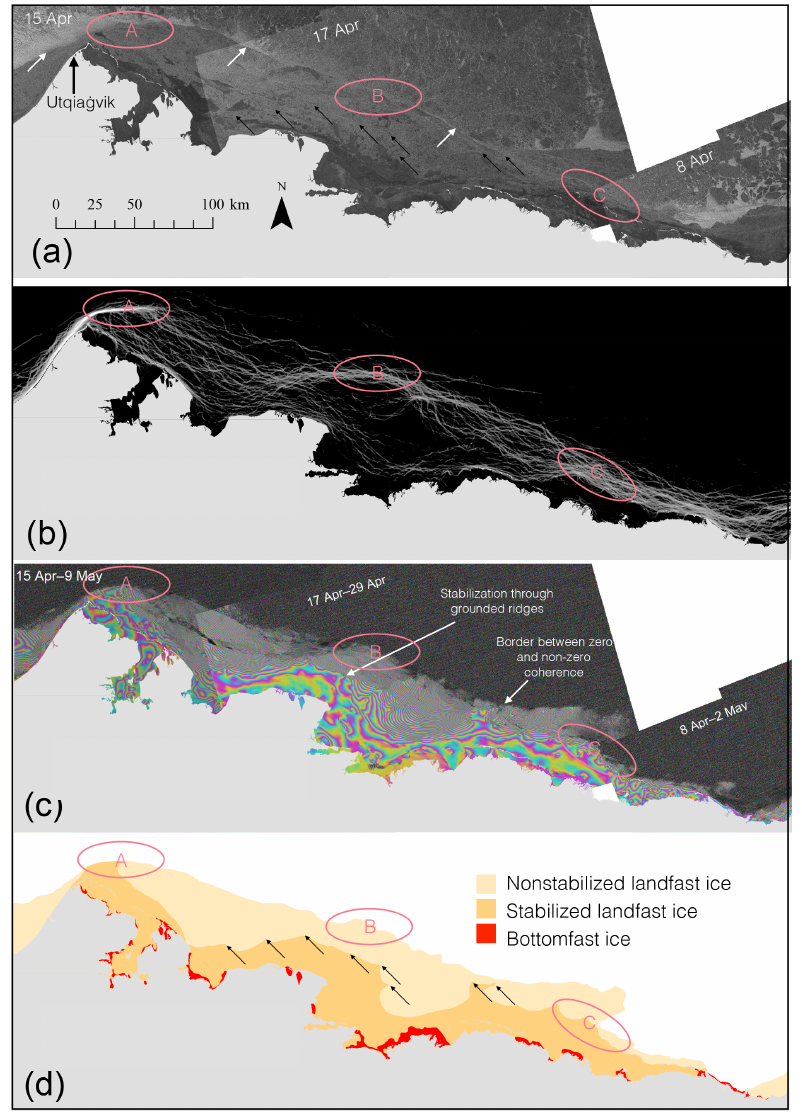
Figure 12. (a) Sentinel-1 backscatter images over the western Beaufort Sea. White arrows signify the landfast ice edge as identified by contrasting backscatter. (b) Landfast ice edge occurrence mapped for the period 1996–2008 over the Alaska Beaufort Sea (Mahoney et al., 2014). Light red circles correspond to areas of frequent landfast ice edge formation, referred to as “nodes”. (c) Interferograms between mid-April and mid-May 2017. (d) Different stability zones derived from (c) . Potential grounding points as identified in (d) are marked with black arrows in (d, a) . Land is masked out in light